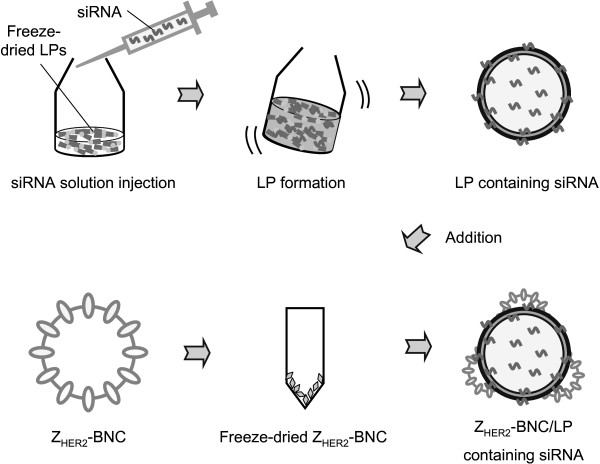
Schematic illustration for conjugate formation of ZHER2-BNC/LP complex containing siRNA.